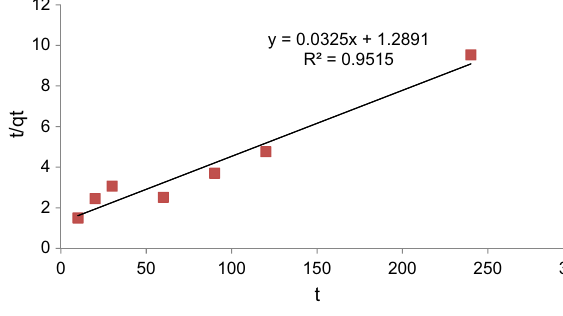
Fig. 8 Pseudo-second-order plot of Cd(II) onto UMSFS